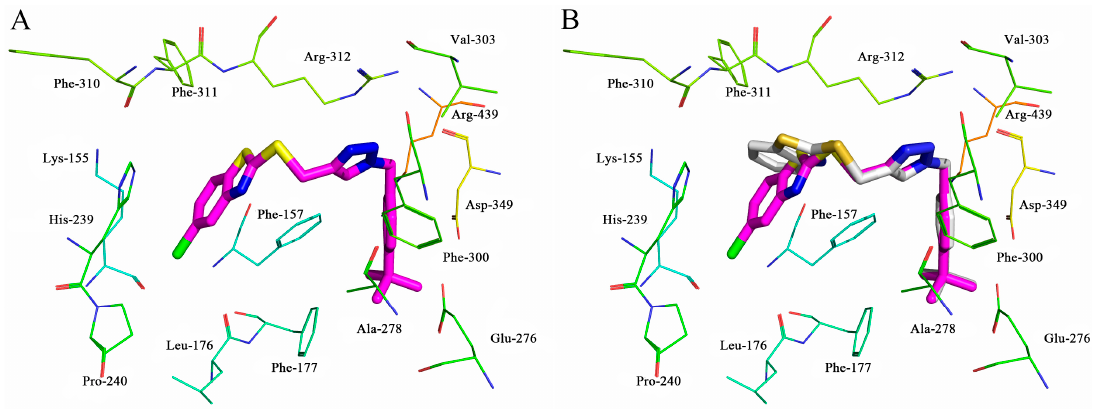
Figure 3. ( A ) Compound 6s was docked to the binding pocket of the Saccharomyces cerevisiae α -glucosidase; α -glucosidase; ( B ) Compounds 6i and 6s were docked to the binding pocket of the ( B ) Compounds 6i and 6s were docked to the binding pocket of the Saccharomyces cerevisiae α - glucosidase (overlapped).